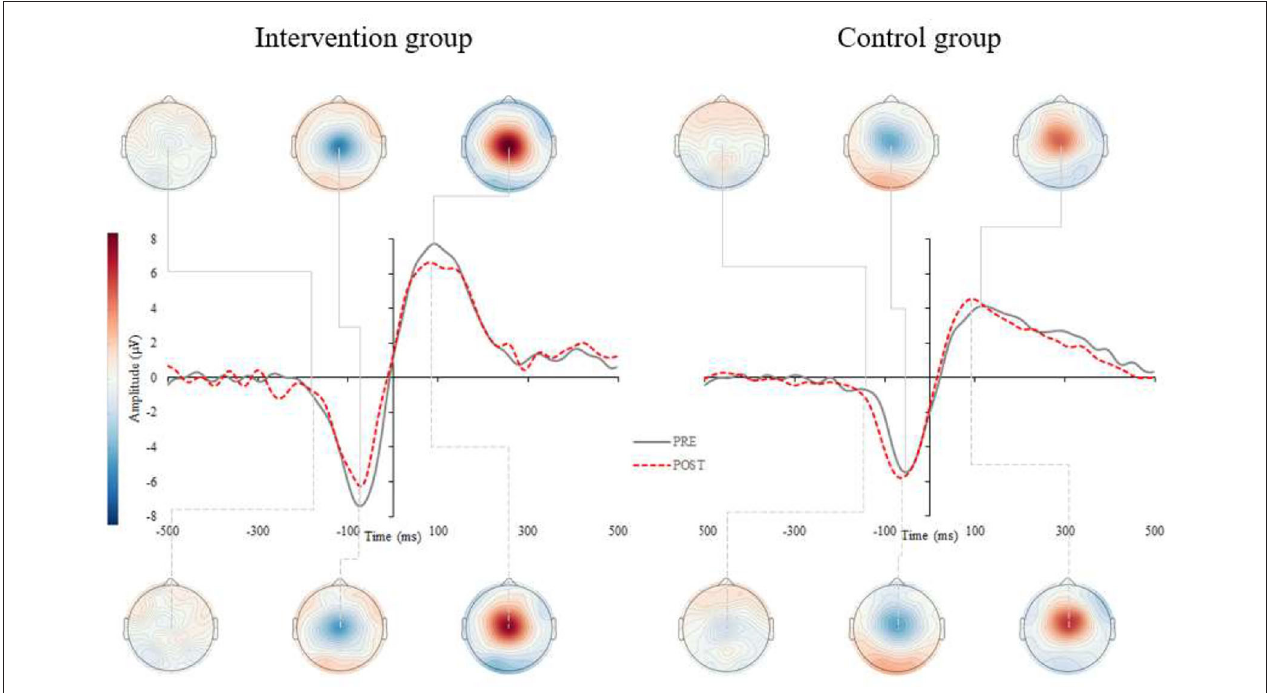
FIGURE 3 | Grand average response-locked event-related potentials (r-ERPs) for the intervention (left) and control (right) group. Figure represents the grand averaged ERPs for pre- (gray, solid) and post-assessments (red, dashed) for intervention (left) and control group (right). The r-ERPs (MRCP) correspond to central electrode Cz and show the peak latency and amplitude of the most negative displacement of the MRCP, prior to or at the time of response